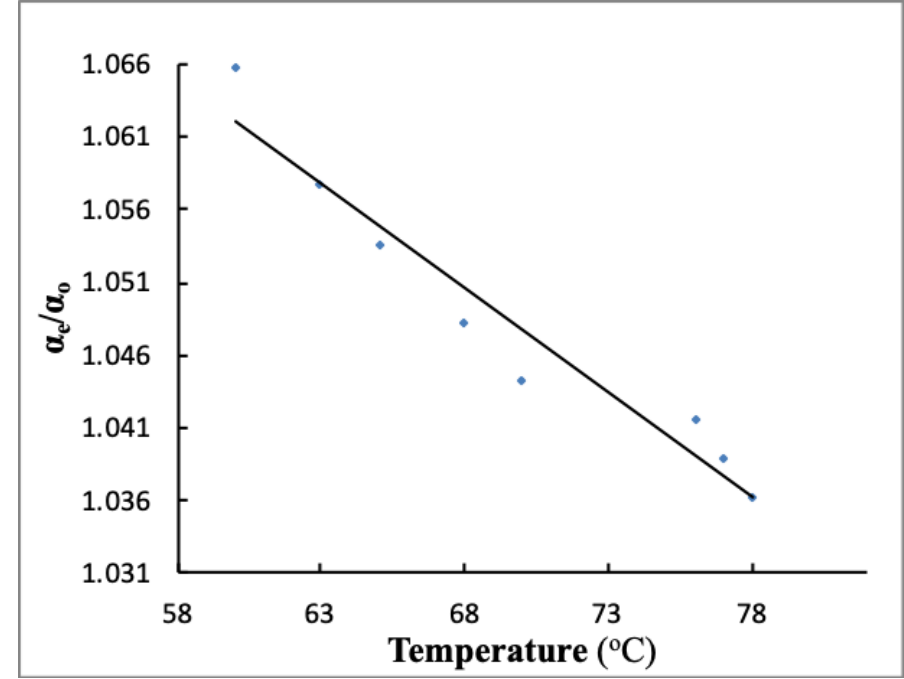
Figure 12. The relationship between the molecular polarizability and temperature for compound I .